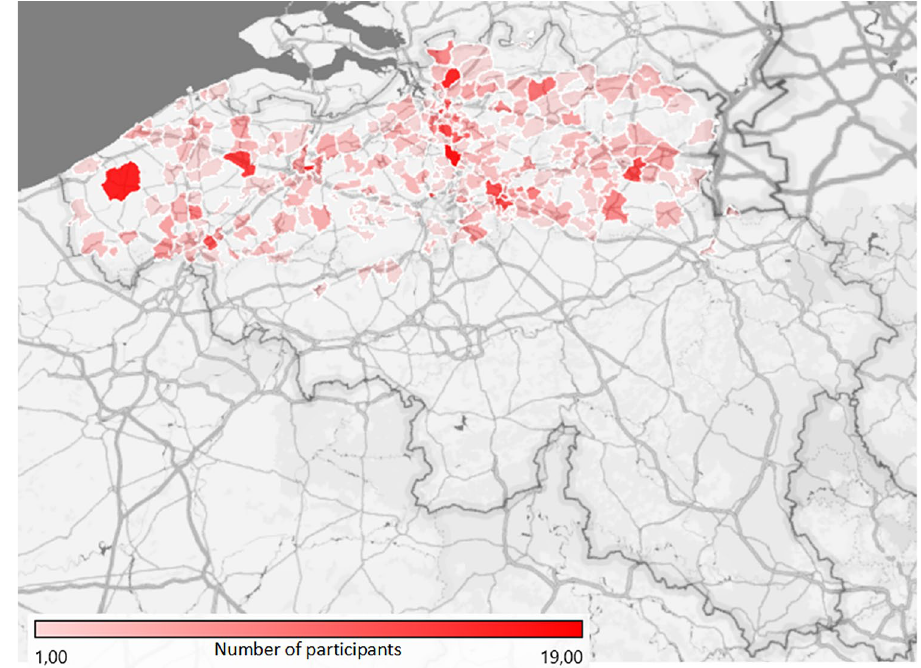
Figure 2. Spreading of participants across Flanders. Map generated with Microsoft Excel (2016).